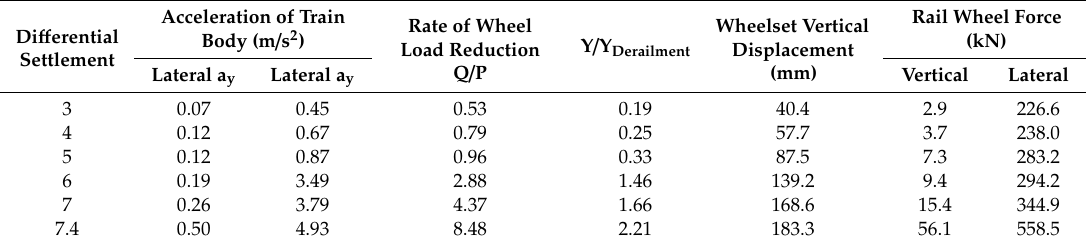
Table 2. Influence of di ff erent di ff erential settlements (mm) of road bridge transition sections on vehicle’s dynamic